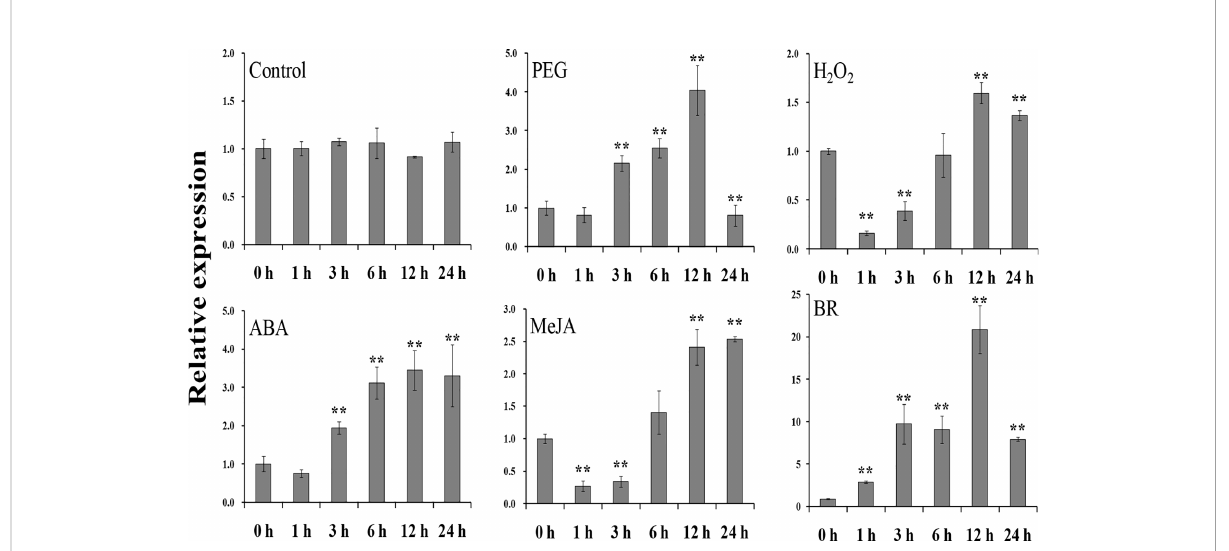
FIGURE 1 Expression analysis of IbEGF in in vitro -grown Xushu55-2 plants after different time points (h) in response to H 2 O (control), 30% PEG6000, 100 mM H 2 O 2 ,100 mM ABA, 100 m M MeJA and 100 nM BR, respectively. The expression level of IbEGF in the plant sampled at 0 h was set to 1. The data are presented as the means ± SEs (n = 3). ** indicates a signi fi cant difference from that of the untreated control (0 h) at P <0.01 according to Student ’ s t